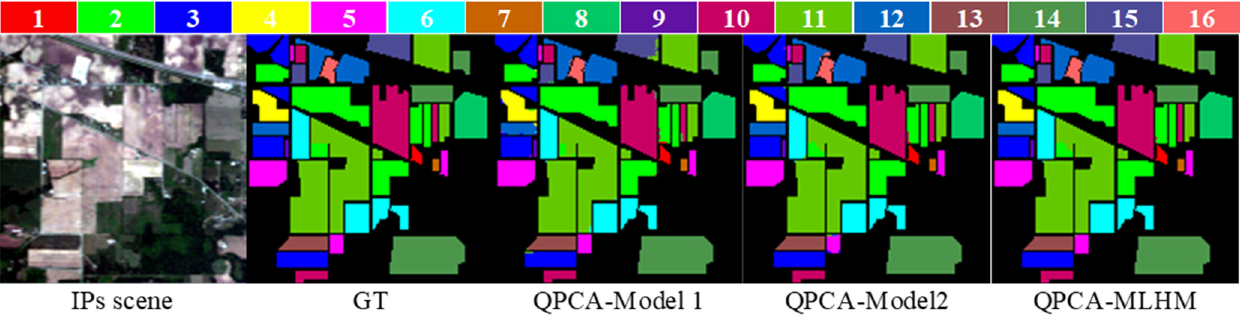
Figure 4. The results of both levels models for the IPs dataset.